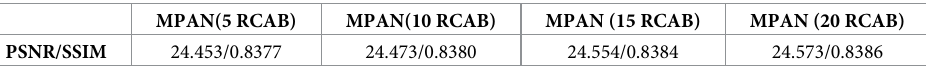
Table 3. Ablation study about RCAB